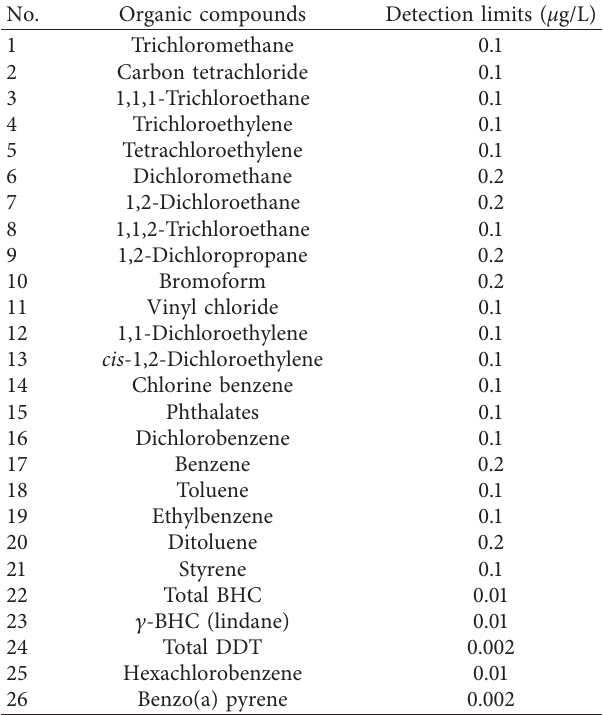
Table 2: Detection limits of the organic